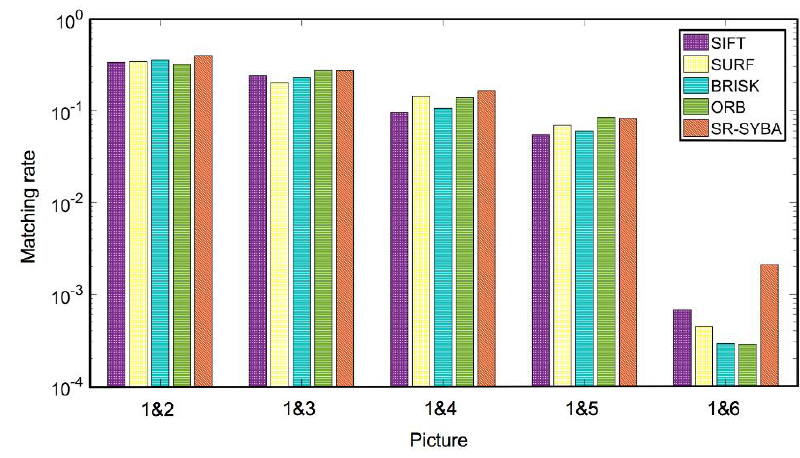
Figure 15. The boat image sequence in the Oxford Affine dataset.